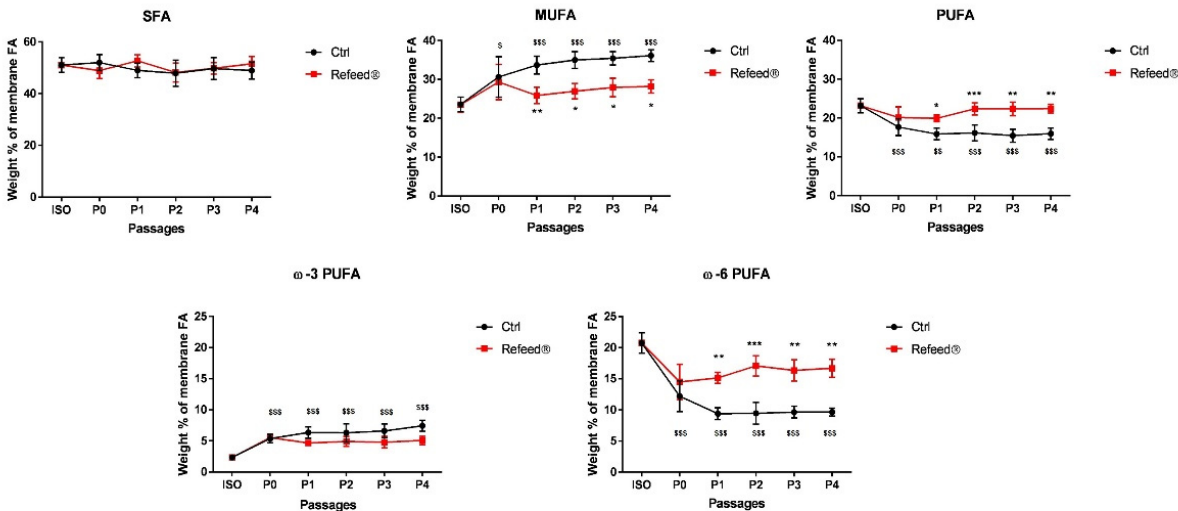
Figure 2. Membrane fatty acid profile of human Amniotic Epithelial Cells (hAECs) cultured with and without Refeed ® supplementation. Membrane fatty acid profile of freshly isolated hAECs (ISO), and of hAECs cultured in basal medium without (Ctrl) or with Refeed ® at passages P0, P1, P2, P3, and P4. Data are expressed in weight % of total membrane fatty acids and presented as mean ± standard deviation (SD). * indicates the statistical significance between Ctrl and Refeed ® at P0, P1, P2, P3, and P4 (* p < 0.05, ** p < 0.01, *** p < 0.001). $ indicates the statistical significance between ISO and Ctrl at P0, P1, P2, P3, and P4 ( $ p < 0.05, $$ p < 0.01, $$$ p < 0.001). SFA, saturated fatty acids; MUFA, monounsaturated fatty acids; PUFA, polyunsaturated fatty acids; ω -3 PUFA, omega-3 fatty acids; ω -6 PUFA, omega-6 fatty acids. The experiment was performed on six human samples in technical